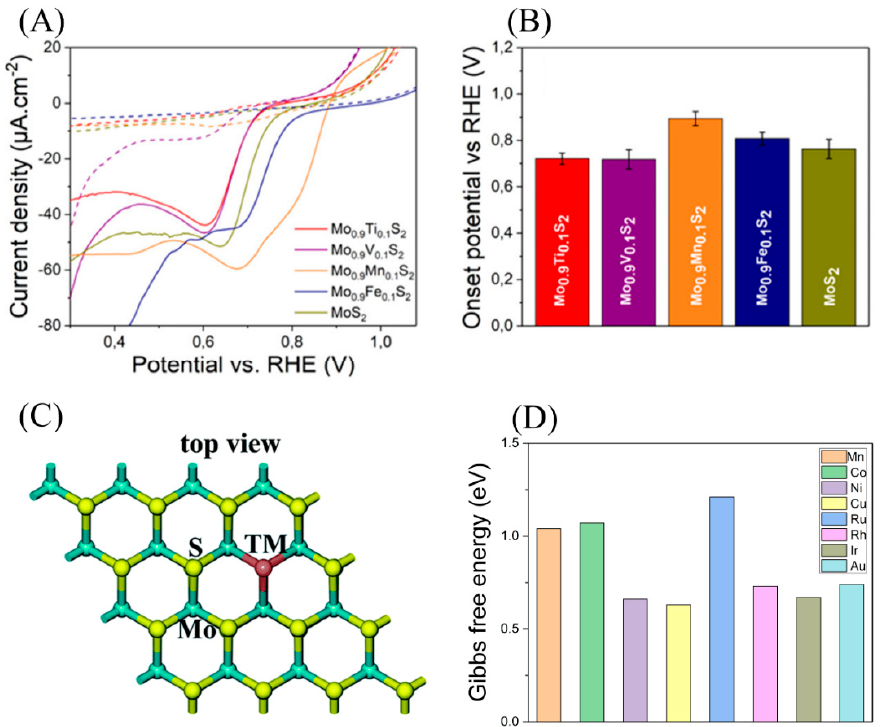
Figure 9. ( A ) Typical linear sweep voltammetry (LSV) curves toward ORRs with the corresponding values of onset potentials ( B ). Reproduced with permission from [90] Copyright © 2021 The American Chemical Society. ( C ) Schematic of a transition atom that embeds into the S vacancy of the MoS 2 monolayer. Reproduced with permission from [92] Copyright © 2021 The Royal Society of Chemistry. ( D ) Schematic of Gibbs free energy diagrams of the ORR on various transition metal